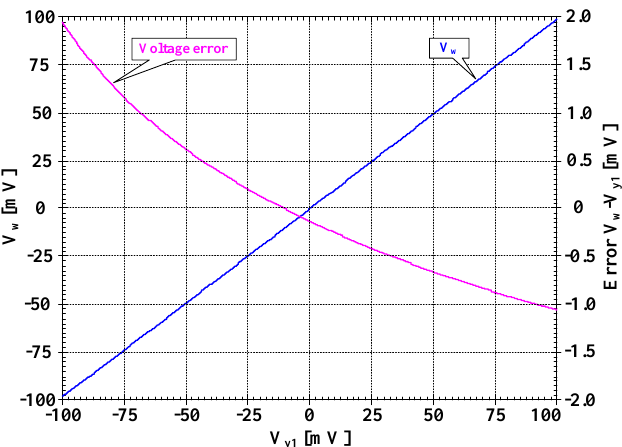
Figure 5. The simulated large signal DC transfer characteristic V W = f(V y1 ) and the corresponding error.